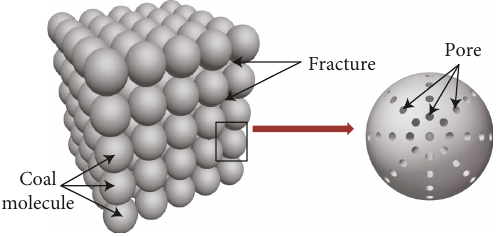
Figure 1: Schematic diagram of coal pore-fracture structure.